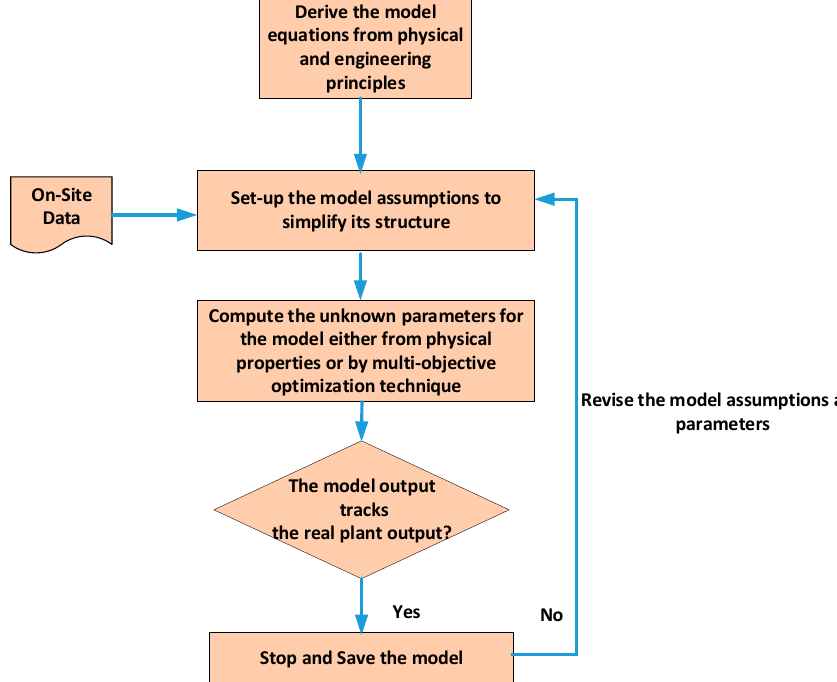
Figure.6 Physical and mathematical model parameters identification flow diagram. Figure 6. Physical and mathematical model parameters identification flow